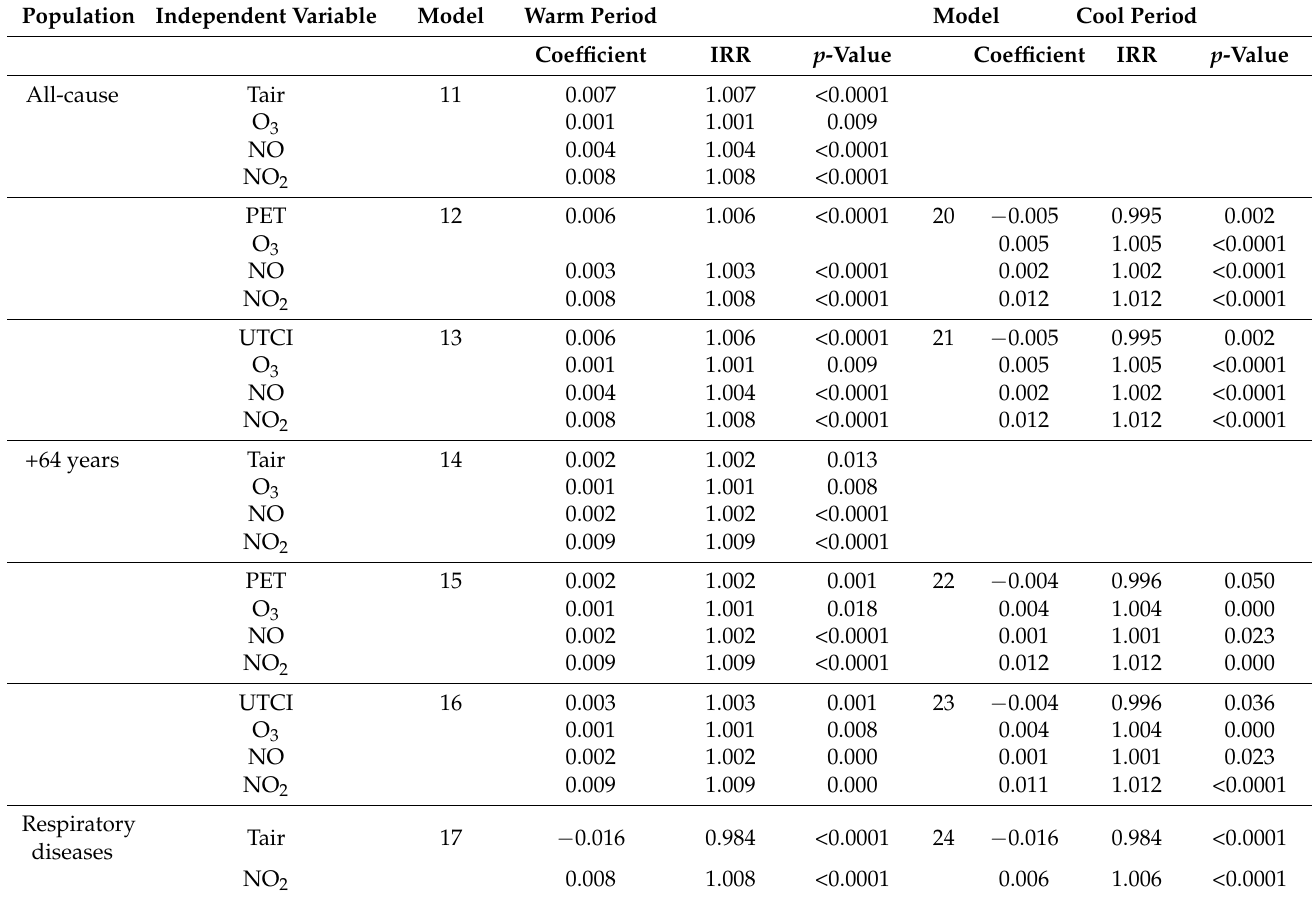
Table 4. Negative binomial regression models for the impact of the thermal environment on the number of hospital admissions (dependent variable) for the warm (April to November) and cool (December to March) period. All models are adjusted for admission year and